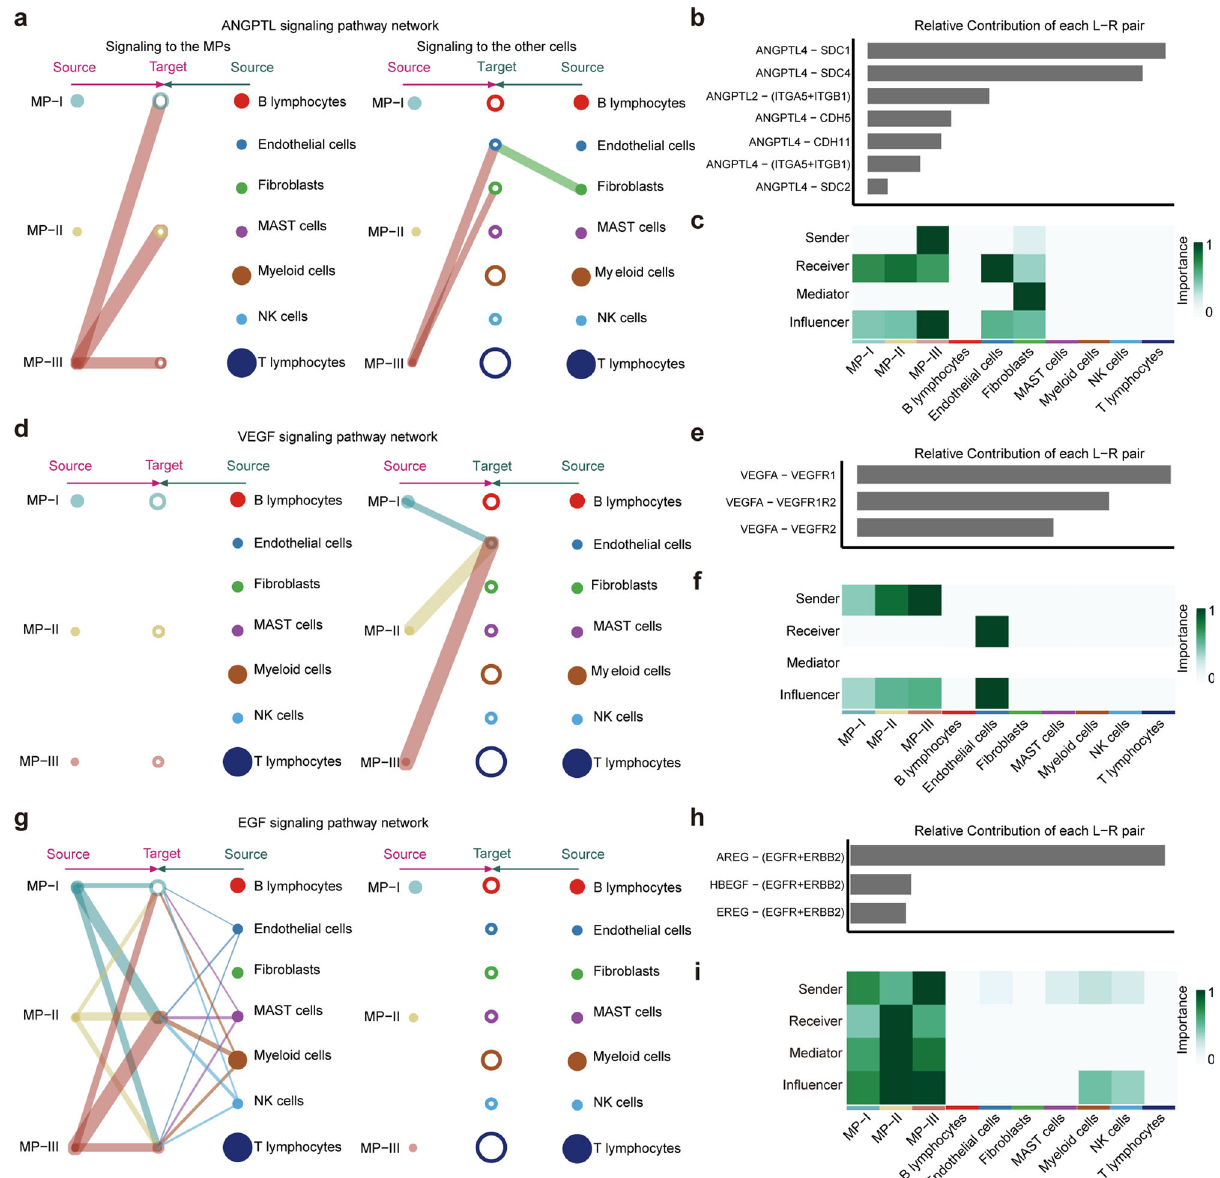
Fig. 7 Network centrality analysis of speci fi c pathways. a Hierarchical plot showing the interactions between the MPs and other cells in the ANGPTL signaling pathway. This plot consists of two parts: Left and right portions highlight the autocrine and paracrine to MPs and to other cells, respectively. Solid and open circles represent source and target, respectively. Circle sizes are proportional to the number of cells in each cell group and edge width represents the communication probability. Edge colors are consistent with the signaling source. b Relative contribution of each ligand-receptor pair to the overall communication network of the ANGPTL signaling pathway. c Relative importance of each cell population based on the computed four network centrality measures of the ANGPTL signaling pathway. Details are described in the original article 57 . d – f VEGF signaling pathway. g – i EGF signaling